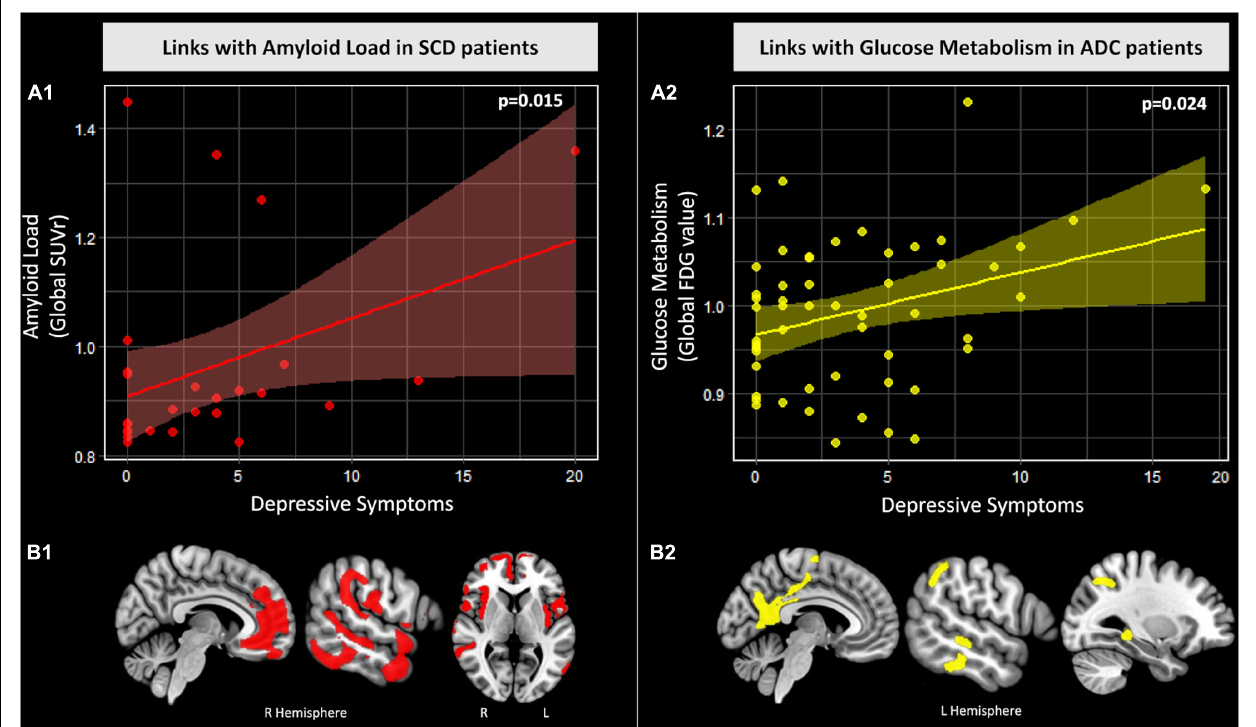
FIGURE 2 | Relationships between depressive symptoms and amyloid load in SCD patients and glucose metabolism in ADC patients. (A) Graphs of the associations between depressive symptoms and global measures of amyloid load in SCD patients (A1) and glucose metabolism in ADC patients (A2) . Reported statistics were obtained from the multiple linear regressions corrected for level of education, age and sex. Raw values are plotted and linear trends and confidence intervals (95%) are represented for SCD patients (red) and ADC patients (yellow). (B) Results of the voxelwise multiple regressions between depressive symptoms and amyloid deposition in SCD patients [ (B1) red] and glucose metabolism in ADC patients [ (B2) yellow]. Analyses were corrected for level of education, age and sex. All results are presented at a p uncorrected < 0.005 threshold combined with a minimum cluster size determined by Monte-Carlo simulations to achieve a corrected statistical significance of p < 0.05 (i.e., k corrected ≥ 1476 voxels for amyloid deposition and k corrected ≥ 1757 voxels for glucose metabolism). ADC , Alzheimer’s continuum; FDG , 18F-fluorodeoxyglucose; L , Left; p , p -value; R , right; SCD , subjective cognitive decline; SUVr , standardized uptake value ratio.